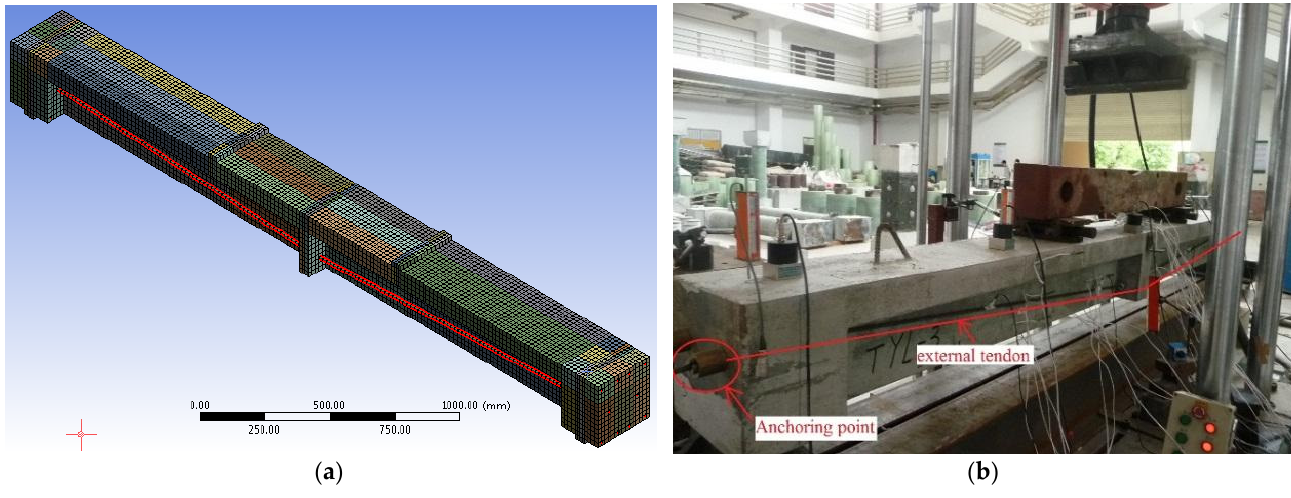
Figure 6. Profile of the external tendon and loading: ( a ) finite element; ( b ) laboratory. The failure stages of the original unstrengthened sample (S 0 ) and the six strengthened samples (S 1 , S 2 , S 3 , S 4 , S 5 , and S 6 ) under the same loading conditions were approximately similar to each other. Therefore, the failure stages of the sample S 0 only are presented below For the sample S 0 (control beam), the first micro-crack was recorded at the bottom of the beam in the middle-third part when the load reached 8 kN and the maximum deflection was less than 1 mm. At this point, the load was listed as a cracking load, as shown